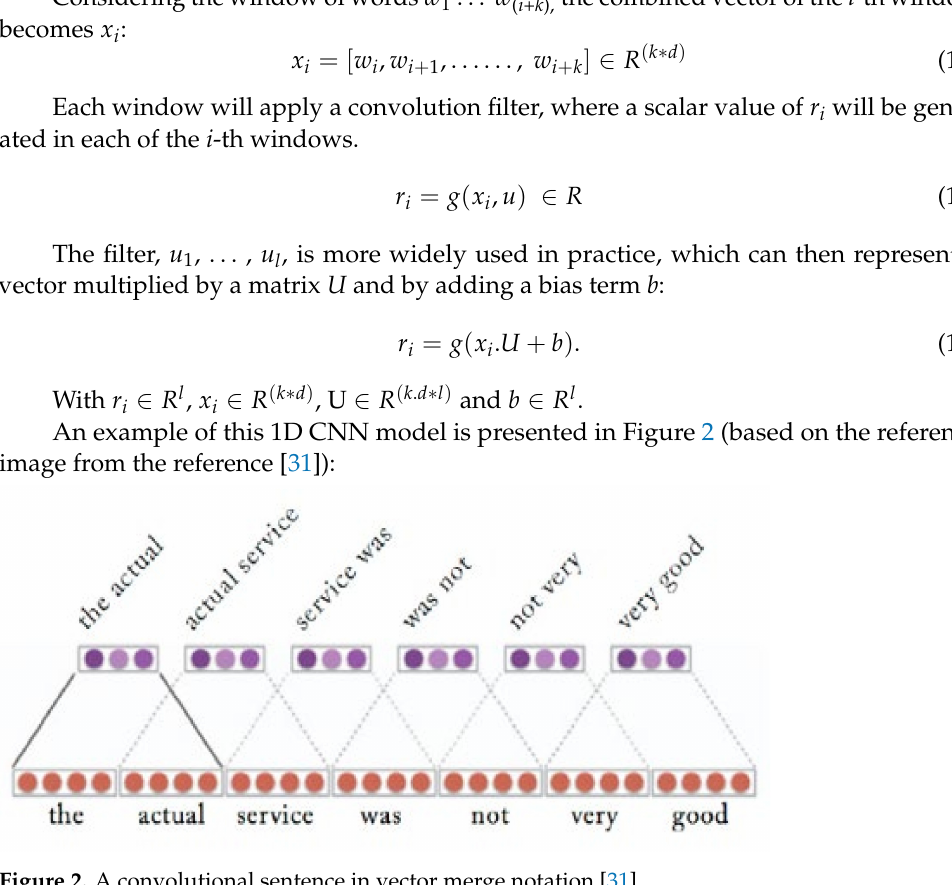
Figure 2. A convolutional sentence in vector merge notation